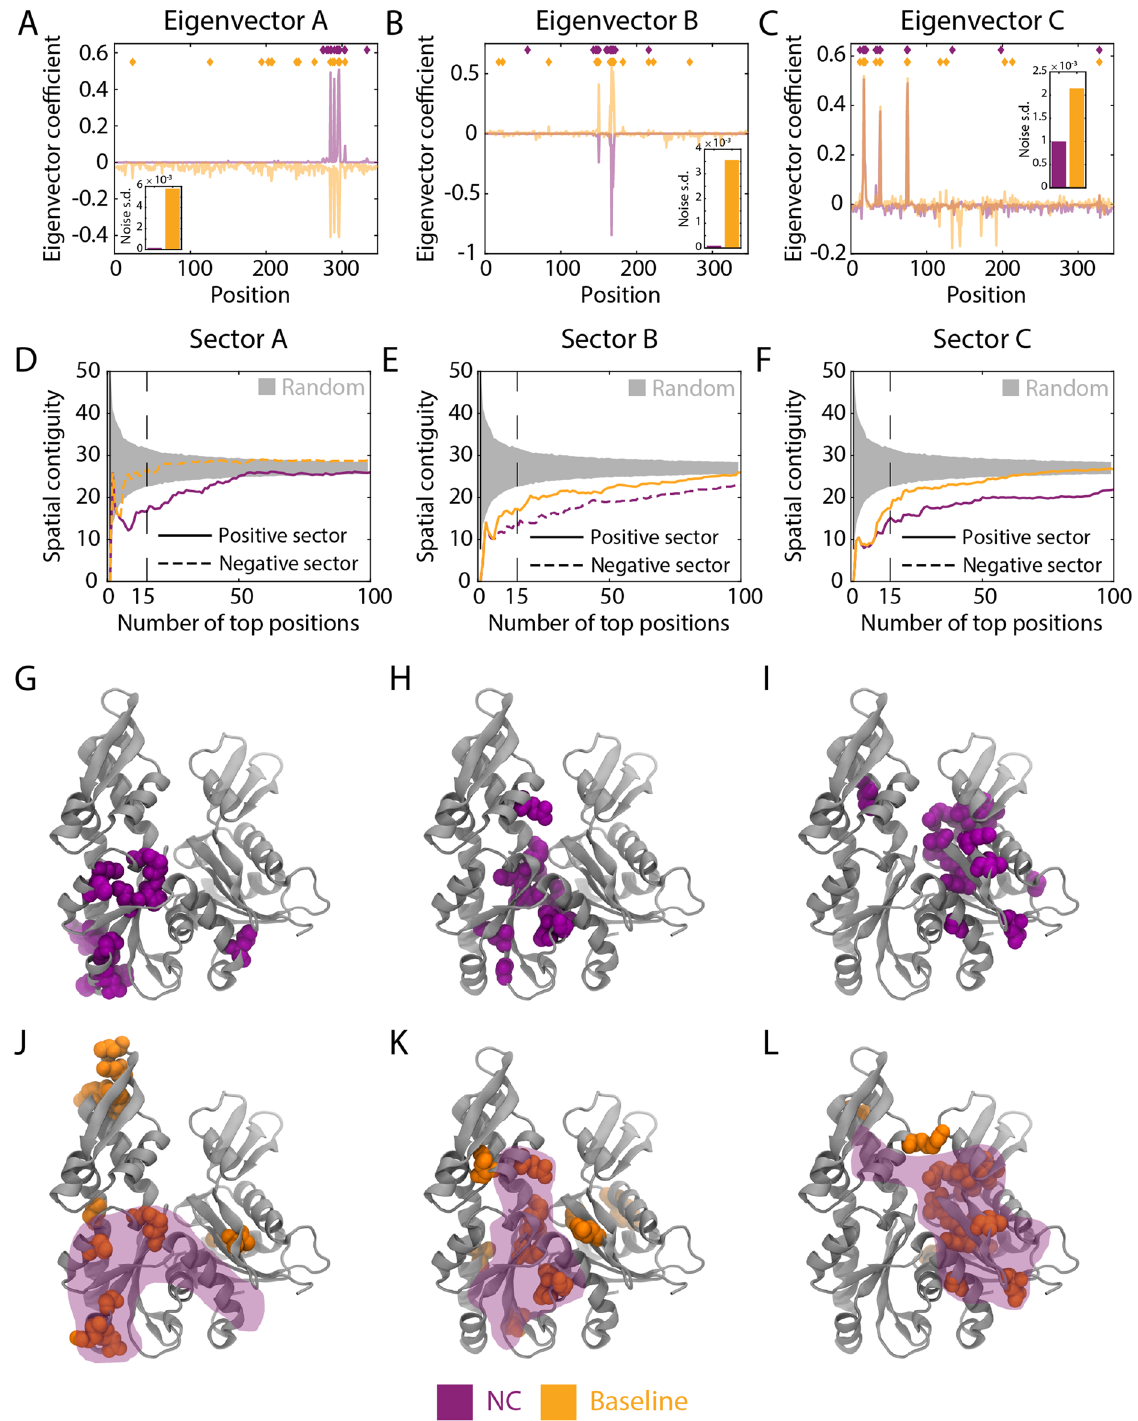
Figure 3. NC eigenvectors for the actin homolog MreB have lower noise and are more spatially contiguous than baseline eigenvectors. ( A – C ) Three eigenvectors with large eigenvalues were identified and paired between baseline coevolution (NMI with APC) and the NC correction for an MSA containing 9998 sequences of MreB. Aside from the residues with large coefficients, the NC eigenvectors exhibited lower signal variation than the baseline eigenvectors. Insets: standard deviations of the eigenvector coefficients after excluding the highest and lowest 50 values. ( D – F ) NC sectors are more spatially contiguous than the corresponding baseline sectors. Sectors were defined based on a sliding cutoff of the most positive or most negative coefficients of each eigenvector in ( A – C ). Spatial compactness was defined as the mean pairwise distance between each residue within a sector. Gray regions represent 95% confidence intervals of a randomly selected group of residues of the same size. ( G – L ) For the 15-residue versions of the NC and baseline sectors [vertical lines in ( D – F )], the NC sectors ( G – I ) are more compact on the three-dimensional structure than the corresponding baseline sectors ( J – L ). The shaded purple regions in ( J – L ) represent the NC